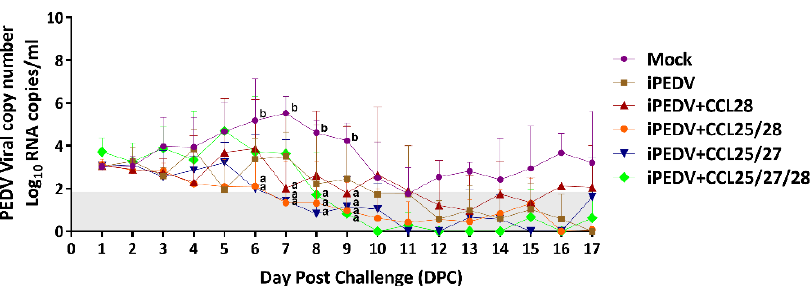
Figure 7. The average mean values of PEDV viral copy numbers detected in the feces of piglets following the virulent PEDVPT-P6 and 7 challenge. The fecal PEDV viral load was detected by a probe-based quantitative reverse transcription PCR (RT-qPCR) and transformed into the log10 copies/mL. The error bars indicate the standard deviation. The limit of detection for RT-qPCR was 1.8 log10 (copies/mL) marked as the gray zone. Statistically significant differences are present between a and b ( p < 0.05).